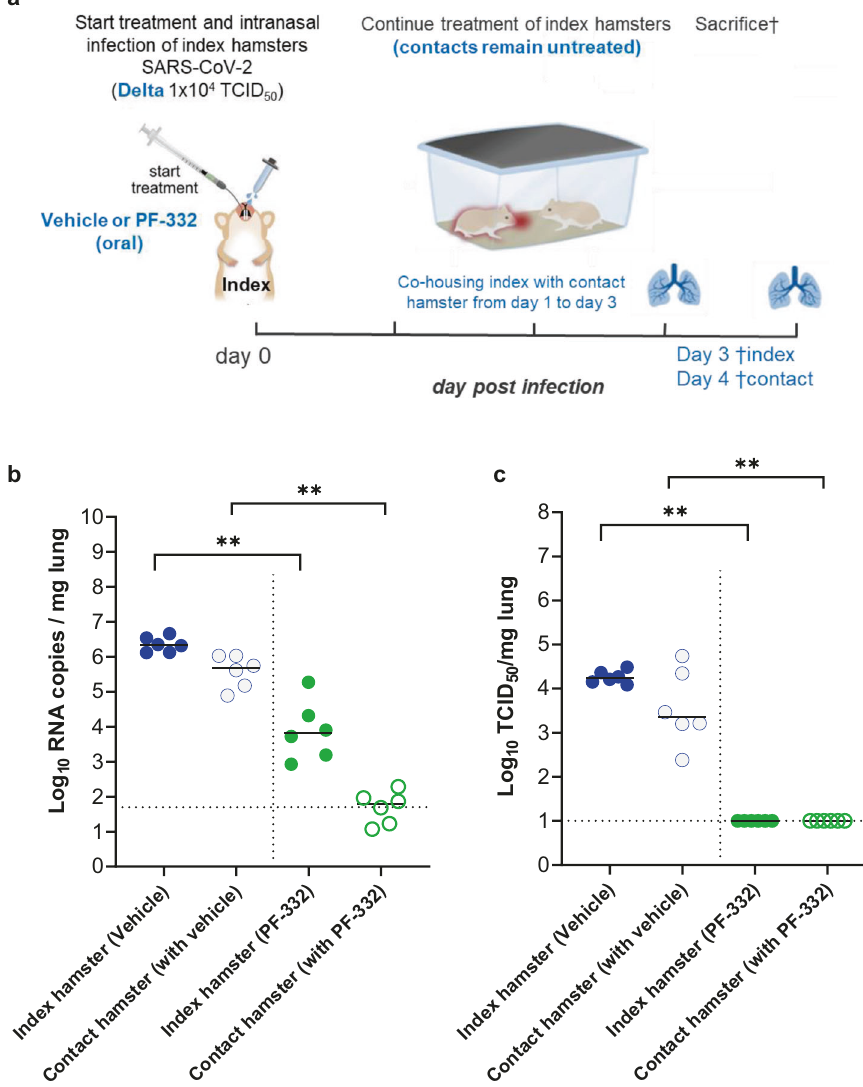
Fig. 3 The effect of treatment with PF-332 on the transmission of the Delta variant to untreated sentinel hamsters. a Design of the study. b Viral RNA levels in the lungs of control (vehicle-treated), PF-332-treated (250 mg/kg, BID) SARS-CoV-2-infected index hamsters (closed circles), and non-infected, non-treated contact hamsters (open circles) at day 3 and 4 post-infection (pi), respectively, are expressed as log 10 SARS-CoV-2 RNA copies per mg lung tissue. Individual data and median values (indicated by bars) are presented. c Infectious viral loads in the lungs of control (vehicle-treated), PF-332-treated SARS-CoV-2 − infected index hamsters, and non-infected, non-treated contact hamsters at day 3 and 4 pi, respectively, are expressed as log 10 TCID 50 per mg lung tissue. Individual data and median values (indicated by bars) are presented. Data in b , c were analyzed with the Mann – Whitney U test (two-sided). ** P = 0.0022. PF-322 = PF-07321332. The data in b , c are from a single experiment and with 6 animals per group. Source data are provided as a Source Data fi